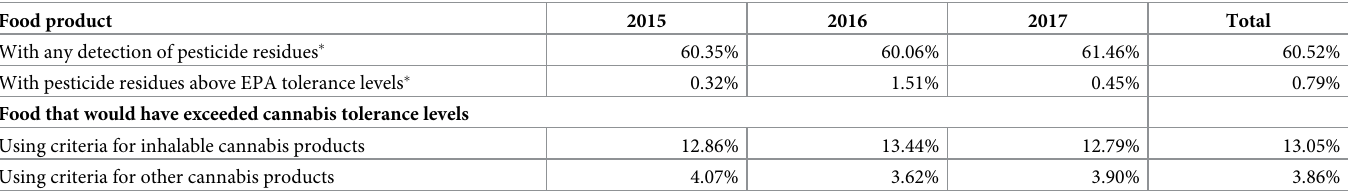
Table 5. Percent of California food product samples indicating any detection of pesticide residues, above EPA tolerance levels, and percent above tolerance levels for cannabis products